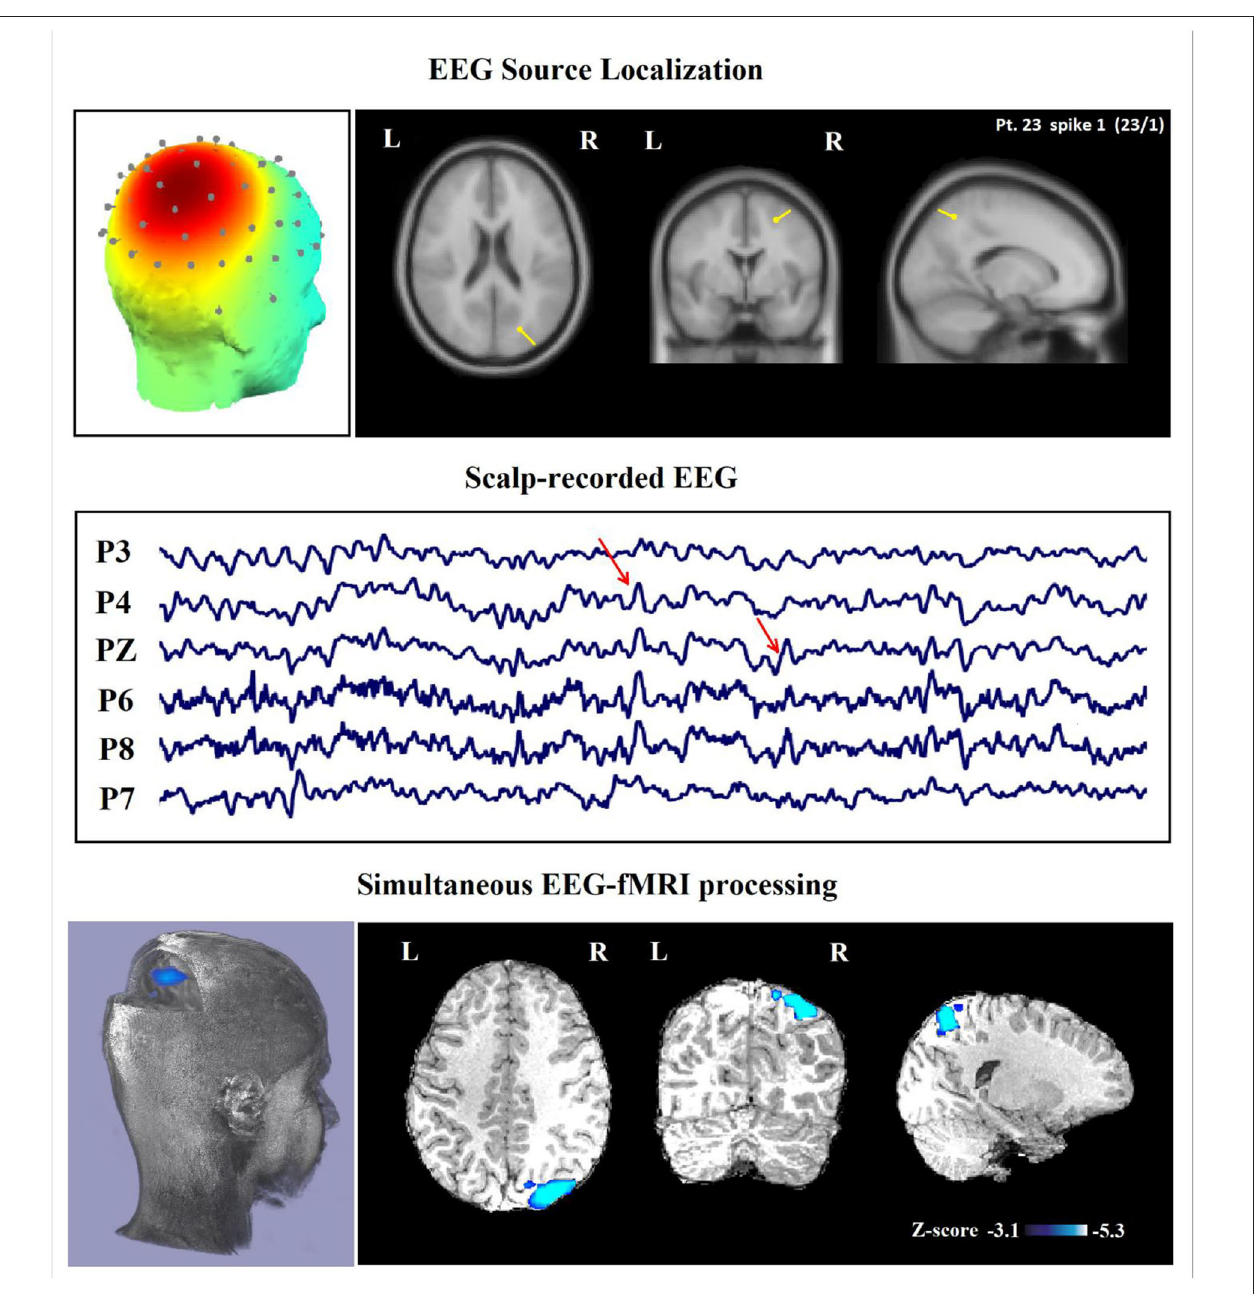
FIGURE 6 | (Patient 23—spike 1) marked events are parietal spikes and wave complexes (referential montage). The TCCC-related BOLD response shows deactivation in the posterior part of the right superior parietal lobule. This BOLD response is considered concordant with the spike field and contributed to a better localization of the epileptic foci compared with the scalp EEG. Top, the component identified on scalp EEG located in the right middle parietal lobe (left) and the dipole localization of the identified generator in brain structures (right) based on analysis of EEG inside the scanner. Middle, scalp recorded EEG. Bottom, Localization of the generator applying simultaneous analysis of EEG-fMRI. The deactivation is marked with a blue-white